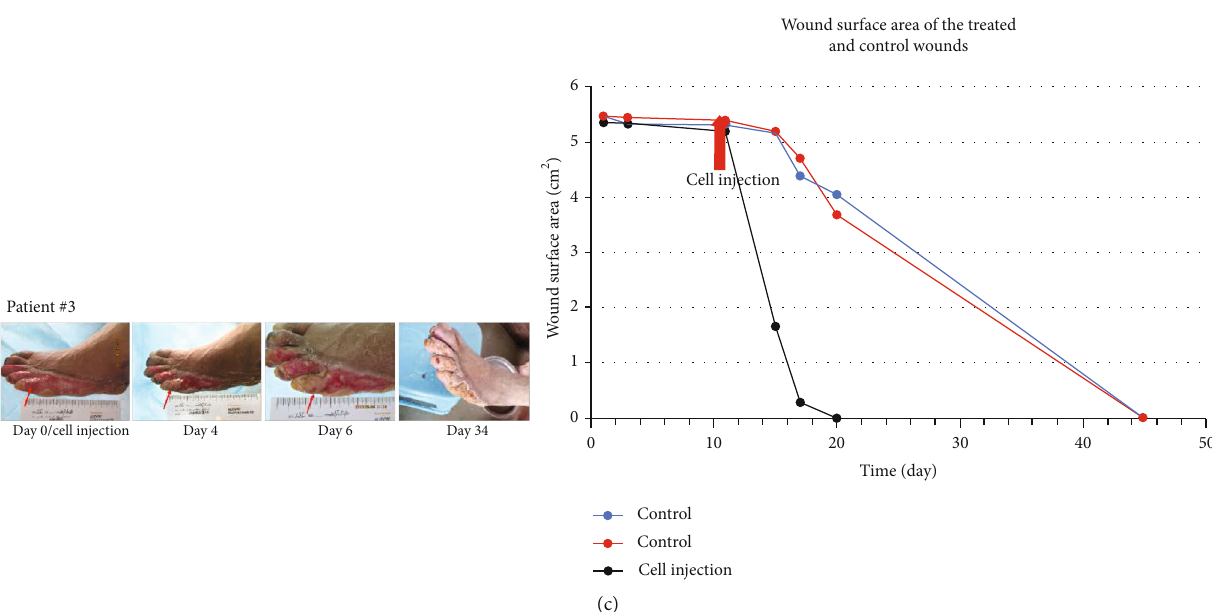
Figure 1: Photographs of treated ulcer (right foot) and control ulcer (left foot) over time with depiction of wound surface area of patient #1 (a). Patient #1 had two wounds in both foots; the right foot was injected cells and the left foot as control. The healing rate of the wound injected cells was obviously faster than control wounds. Photographs of treated ulcer (the fi rst and third toes) and control ulcer (the other two toes) over time with depiction of wound surface area of patient #2 (b). Patient #2 had four wounds in his left foot; the fi rst and third toes were injected cells (red arrow) and the other two toes as control. The healing rate of the toes injected cells was obviously faster than control wounds. Photographs of treated ulcer (the fi fth toe) and control ulcer (the other two toes) over time with depiction of wound surface area of patient #3 (c). Patient #3 had three wounds in his left foot; the fi fth toe was injected cells (red arrow) and the other two toes as control. The wound was covered with white epithelium at the fourth day after cell treatment. The healing rate of the fi fth toe was obviously faster than control wounds. Table 3: Reepithelialization rate, the healing rate within the fi rst week, wound area before debridement, and four weeks after cell injection among seven patients with one refractory wound. Before cell injection After cell injection z P Reepithelialization rate within the fi rst week (cm 2 /week)